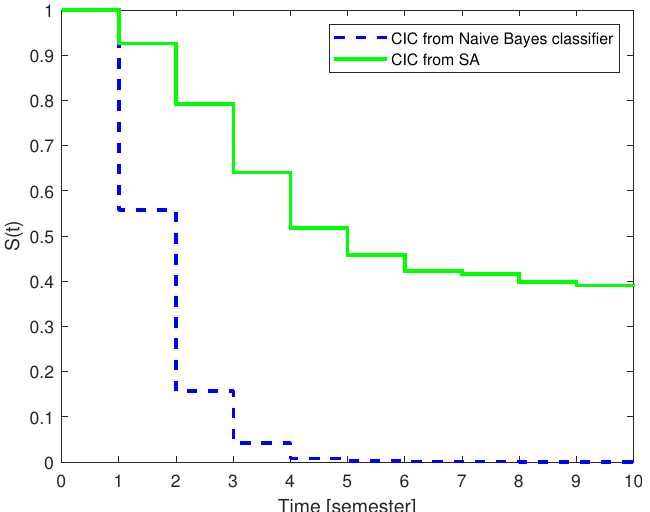
Figure 5. Cumulative Incidence Curves formed from the Naive Bayes classifier (validation dataset— blue) and survival analysis (test dataset—green) for non-graduate students in the case of one-fold change. The functions illustrates well, that the Naive Bayes classifier can poorly predict the dropout of a student.